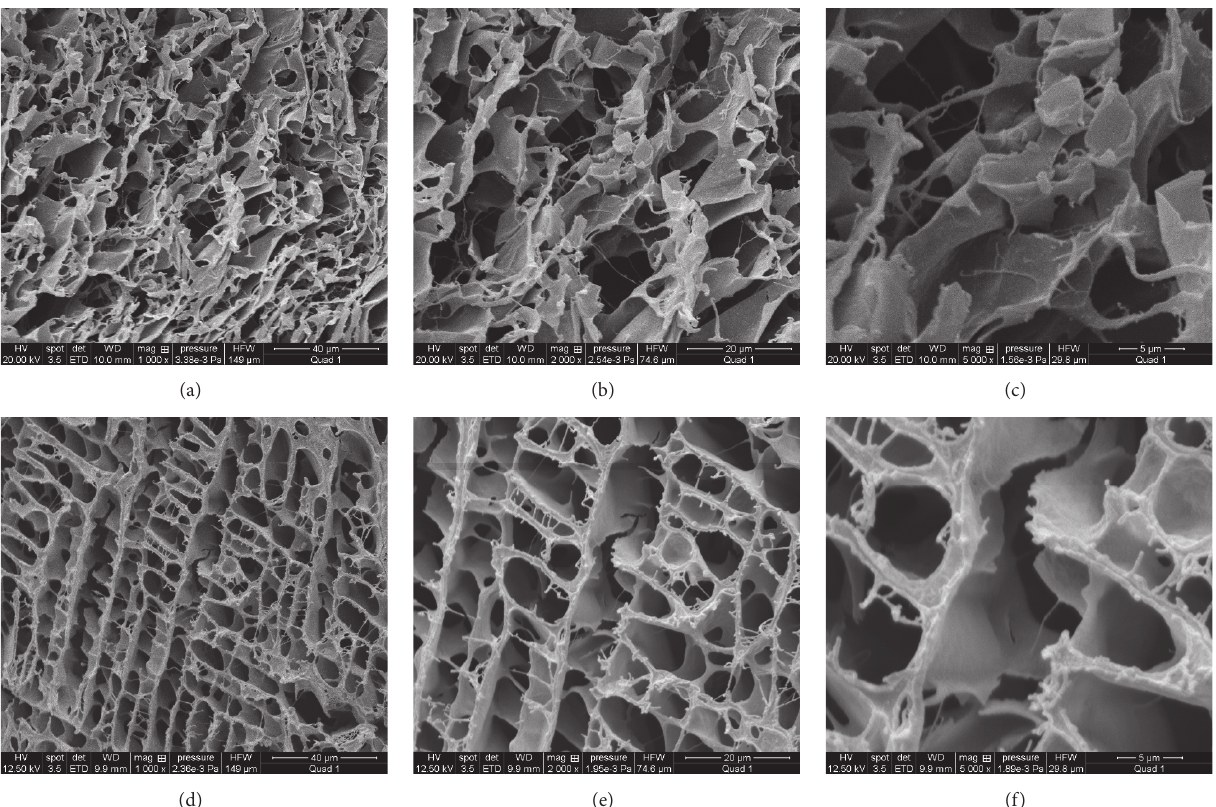
Figure 4: SEM images of PCARW and PCAWDF: (a) PCARW at 40 𝜇 m, 1000x; (b) PCARW at 20 𝜇 m, 2000x; (c) PCARW at 5 𝜇 m, 5000x; (d) PCAWDF at 40 𝜇 m, 1000x; (e) PCAWDF at 20 𝜇 m, 2000x; (f) PCAWDF at 5 𝜇 m,